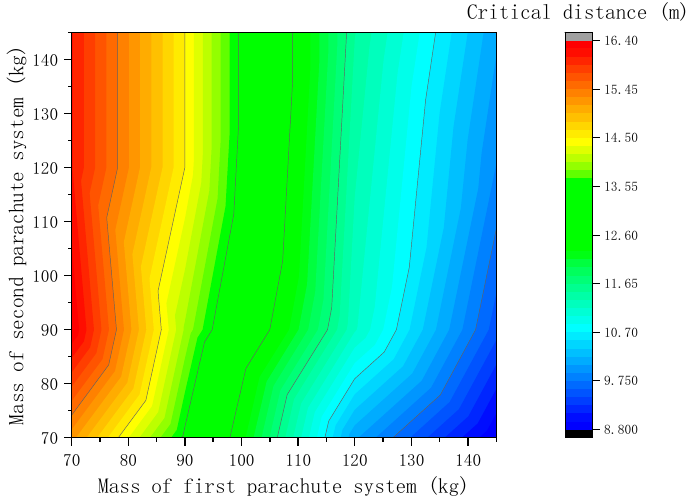
Figure 14. Critical distances between parachute systems with different mass.